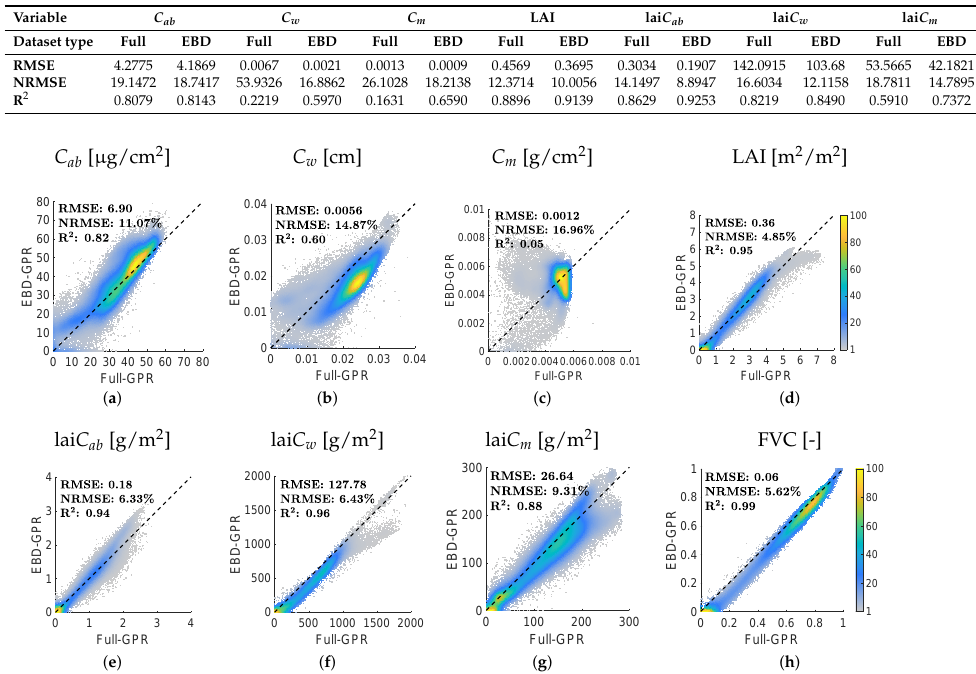
Table 1. Goodness-of-fit results of estimated vs. measured crop traits at the MNI site. Results are given for the GPR model trained with the original datasets (Full) compared to the EBD-optimized datasets (EBD). Units of RMSE for C ab in ( µ g/cm 2 ), for C w in (cm), for C m in (g/cm 2 ), for LAI in (m 2 /m 2 ), for lai C ab , lai C w , and lai C m in (g/m 2 ). NRMSE in %.